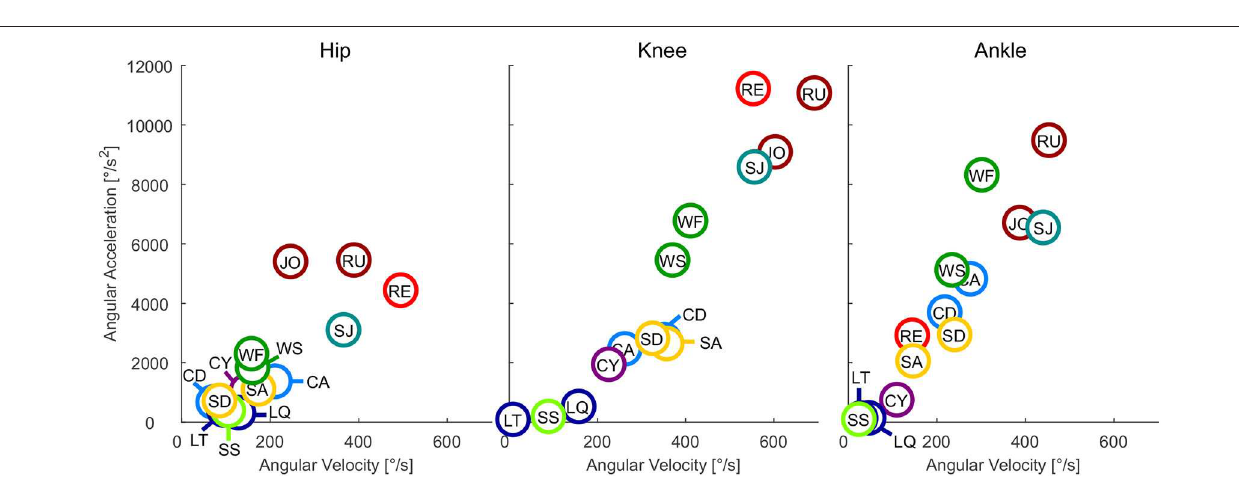
FIGURE 2 | Maximum angular velocity vs. maximum angular acceleration of the hip, knee, and ankle for all analyzed movements. Walking slow (WS), walking fast (WF), climbing descend (CD), climbing ascend (CA), stair ascend (SA), stair descend (SD), jogging (JO), running (RU), cycling (CY), recovery (RE), squat jump (SJ), squat lifting (LQ), stoop lifting (LT), and sit to stand